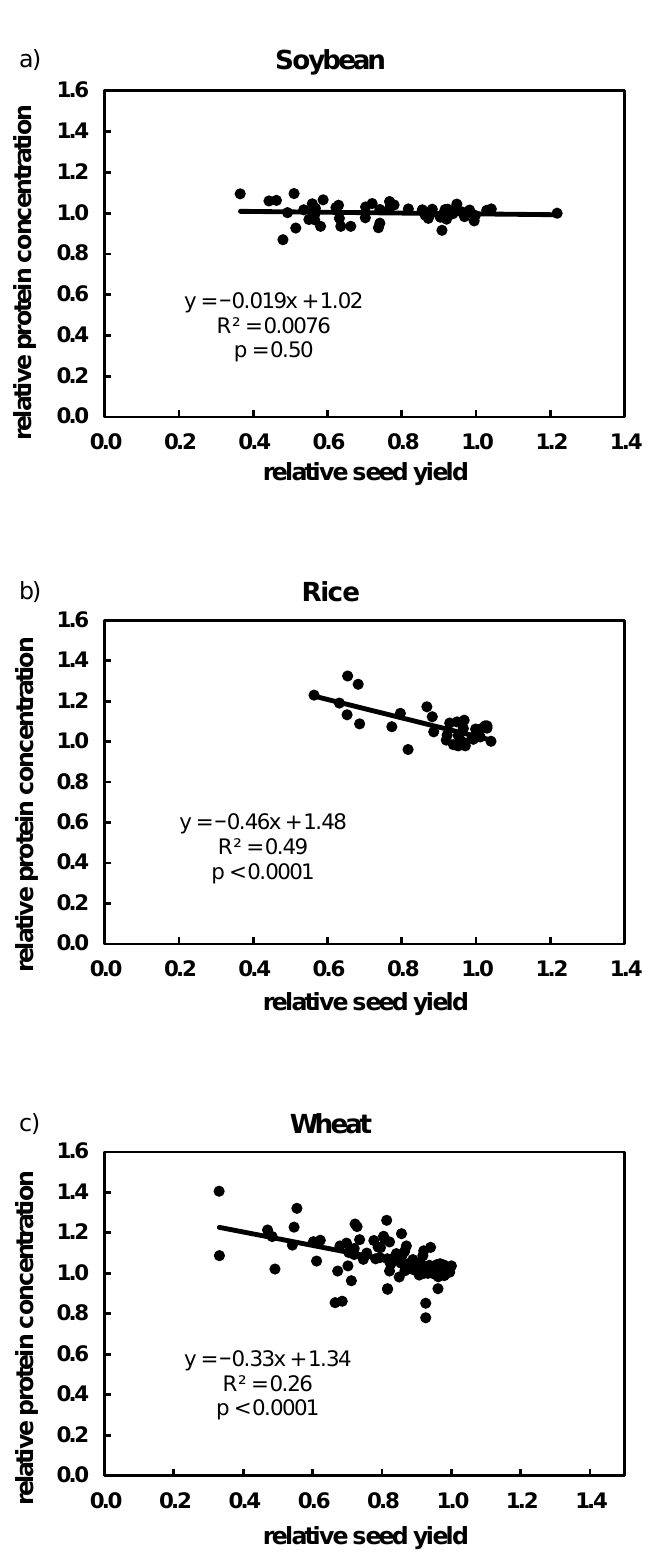
Figure 4. Relationship between the relative levels of seed protein concentration (SPC) and seed yield (SY) from the response regression for ( a ) soybean; ( b ) rice; ( c ) wheat (outliers excluded).